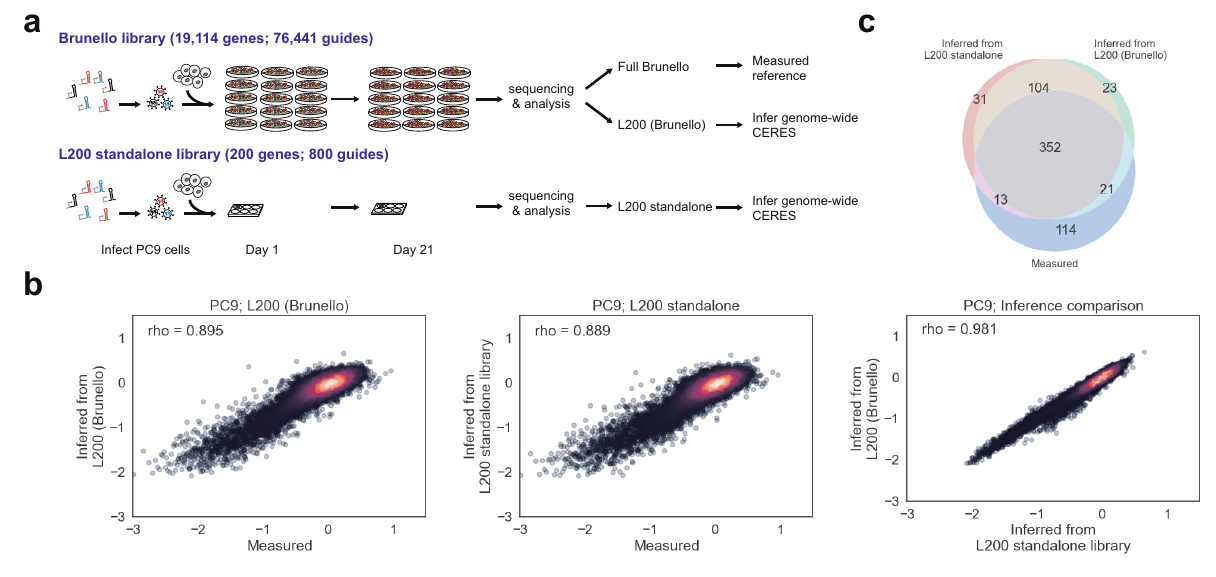
Fig. 6 Direct experimental validation of lossy compression sets. a Two separate pooled screens were performed in a cell line (PC9) that was not included in model training and validation. Experiment 1 was the full Brunello library. A 21-day dropout experiment was performed in PC9 cells. Measurements on 18,114 genes were direct and form the gold standard. The L200 can be computationally extracted from the full screen and compared to these gold-standard measurements. A new L200 standalone library of 800 guides targeting 200 genes was cloned. This library can be used to perform a small-scale lossy compression experiment. The data can then be compared to the gold standard. b Correlations of inferred vs measured CERES scores for both screens in ( a ) and a comparison of the predictions between the standalone sets and the computationally extracted L200 set in the Brunello library. c A Venn diagram describes the overlap in “ Hits ” in the 500 most differentially required genes for growth in PC9 cells. Both of the lossy compression screens from ( a ) and the gold-standard (measured) data are compared. Source data are provided as a Source Data fi